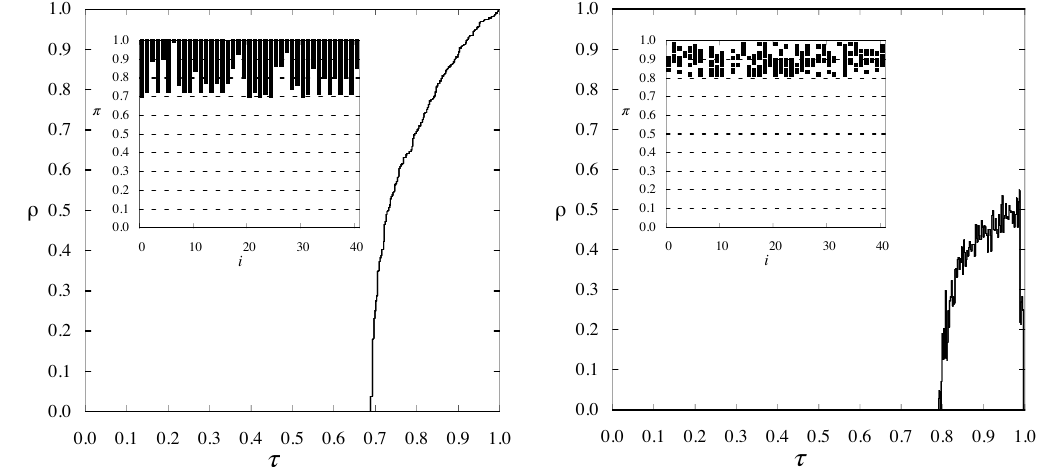
Figure 16. Average density ( ρ ) as a function of the bare infection probability τ and in the inset the distribution of the values of π i for which the infection reaches site i (black bar) for two percolation problems in a regular network with k = 2: ( Left ) site percolation; and ( Right ) “nonlinear” (XOR) percolation. Figures from